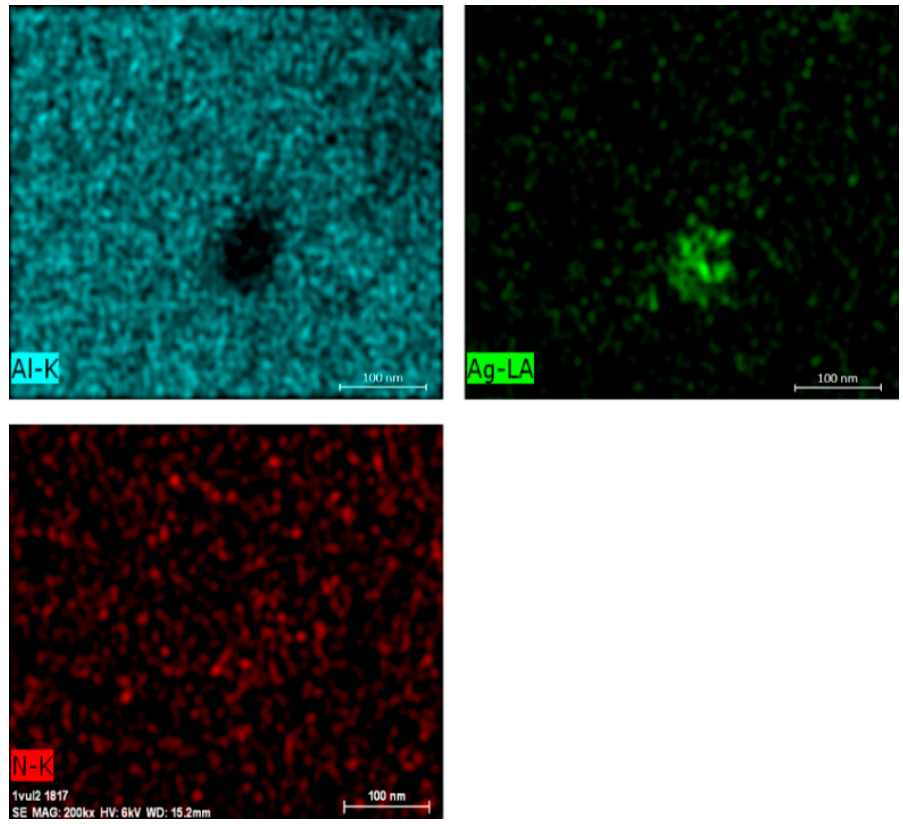
Figure 7. EDX analysis results of deposited nanoparticles.